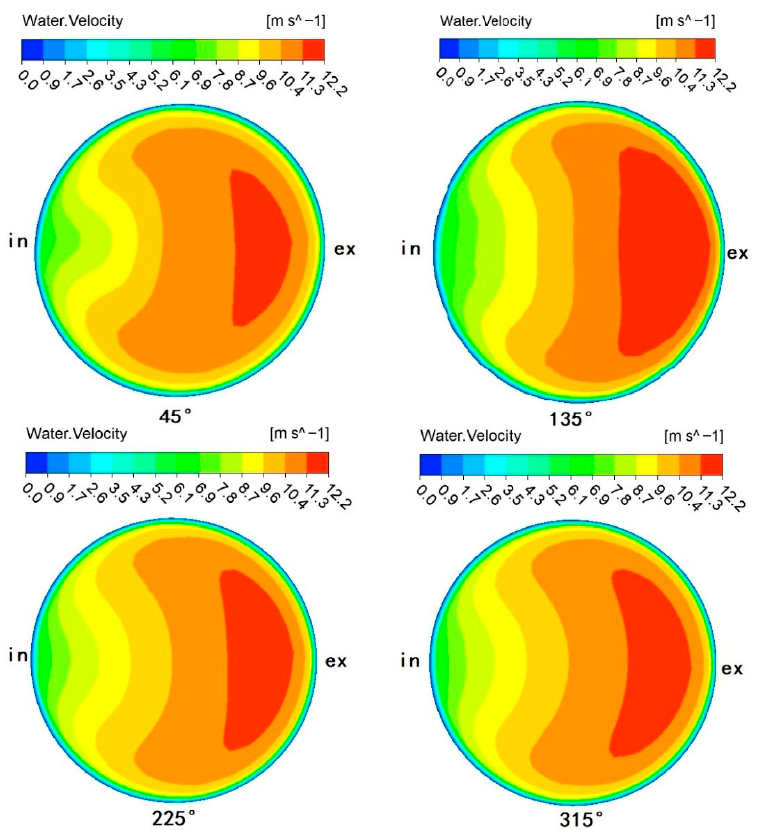
Figure 9. Simulated contours of liquid velocity at different cross-sections ( v in = 10 m/s , α = 0.3 ).